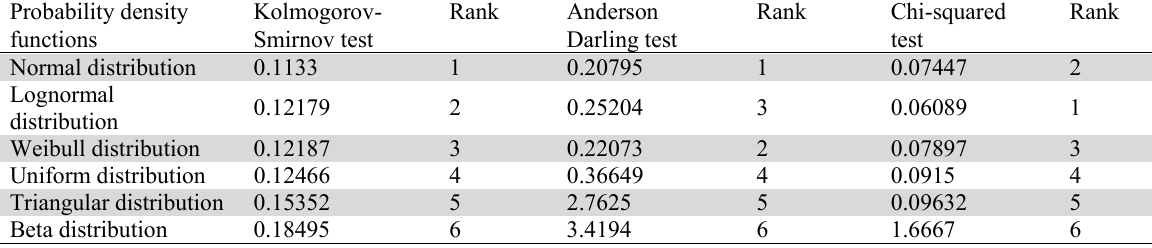
Goodness of fit tests for probability distributions for slabs